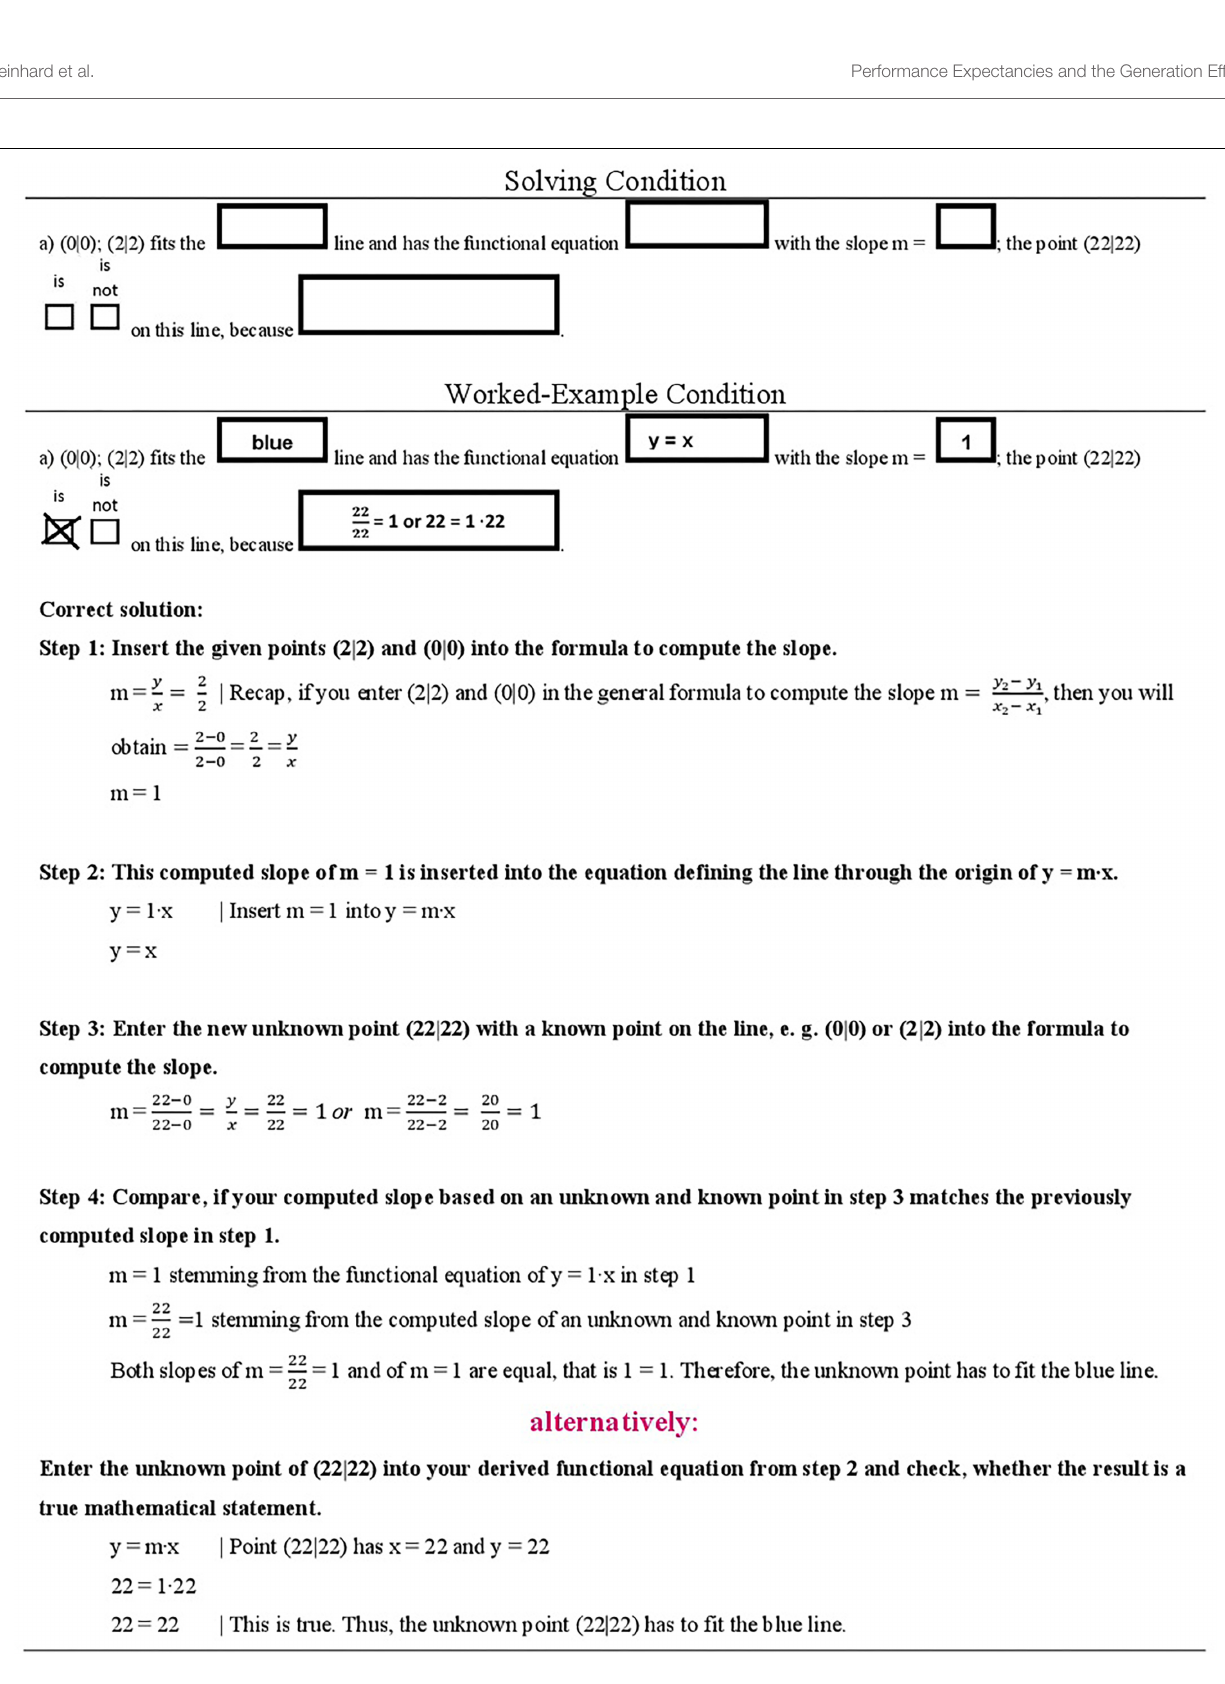
FIGURE 2 | Learning phase: manipulation problem set